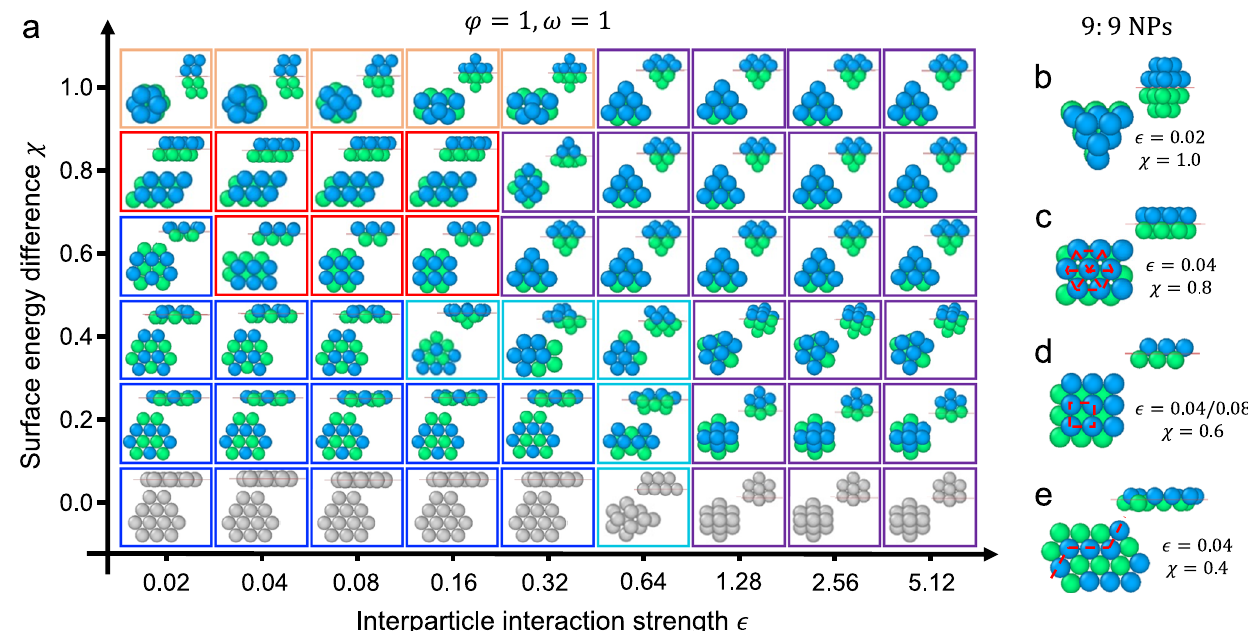
Fig.2|Structuralphasesofanti-symmetricNPs( φ = 1 and ω = 1)predictedfrom optimization.a Phasediagramofstructuresobtainedfromabinary6:6NPsystem plotted with respect to interparticle interaction strength ϵ and surface energy difference χ .ThetwoNPspeciesaredepictedbyblueandgreensphereswhenthey interact differently with the fl uids ( χ ≠ 0) and gray spheres when they interact similarly ( χ =0). The blue, red, orange, and purple boxes mark monolayers,